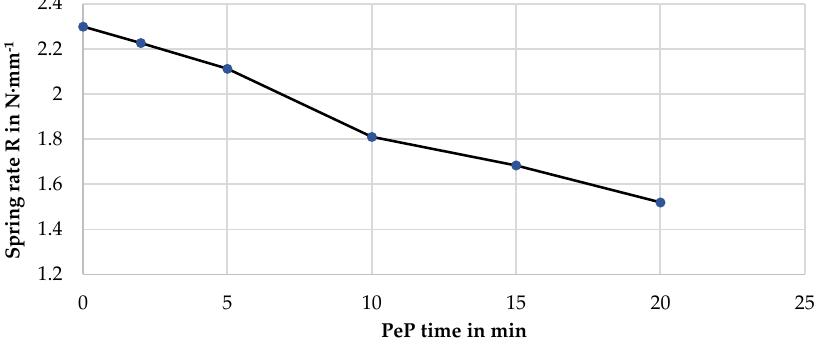
Figure 10. Change of spring rate under compression with increasing PeP time, obtained by linear